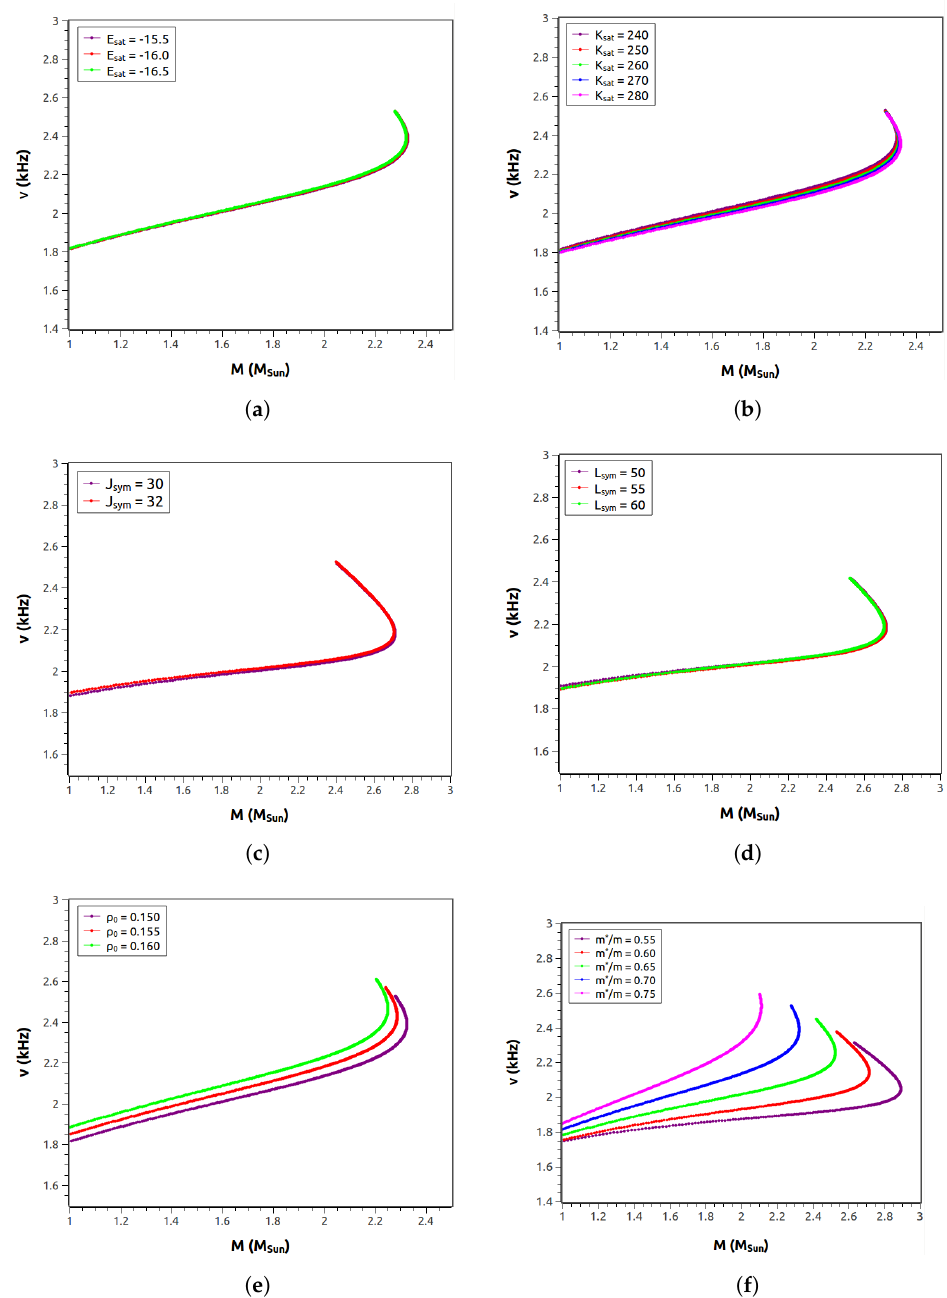
Figure 4. f -mode frequencies, ν , as a function of neutron star mass, M , for equations of state with varying empirical parameters ( a ) energy at saturation E sat , ( b ) compressibility K sat , ( c ) symmetry energy J sym , ( d ) symmetry energy slope L sym , ( e ) saturation density ρ sat , and ( f ) effective mass m ∗ / m